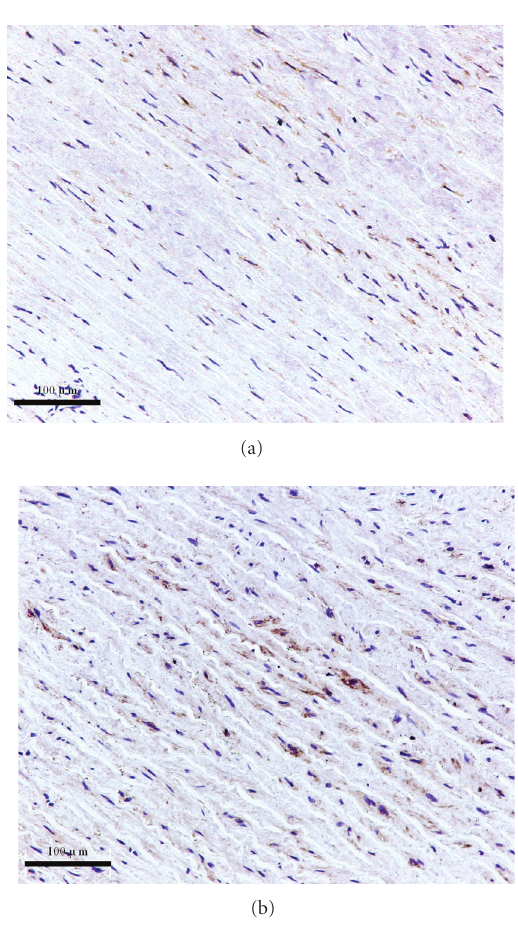
Figure 4: Representative staining pictures of S1P2 in AAAs and control aortic sections ( × 200). S1P2 protein was more pronounced in the normal aortas (b) than that in the AAAs